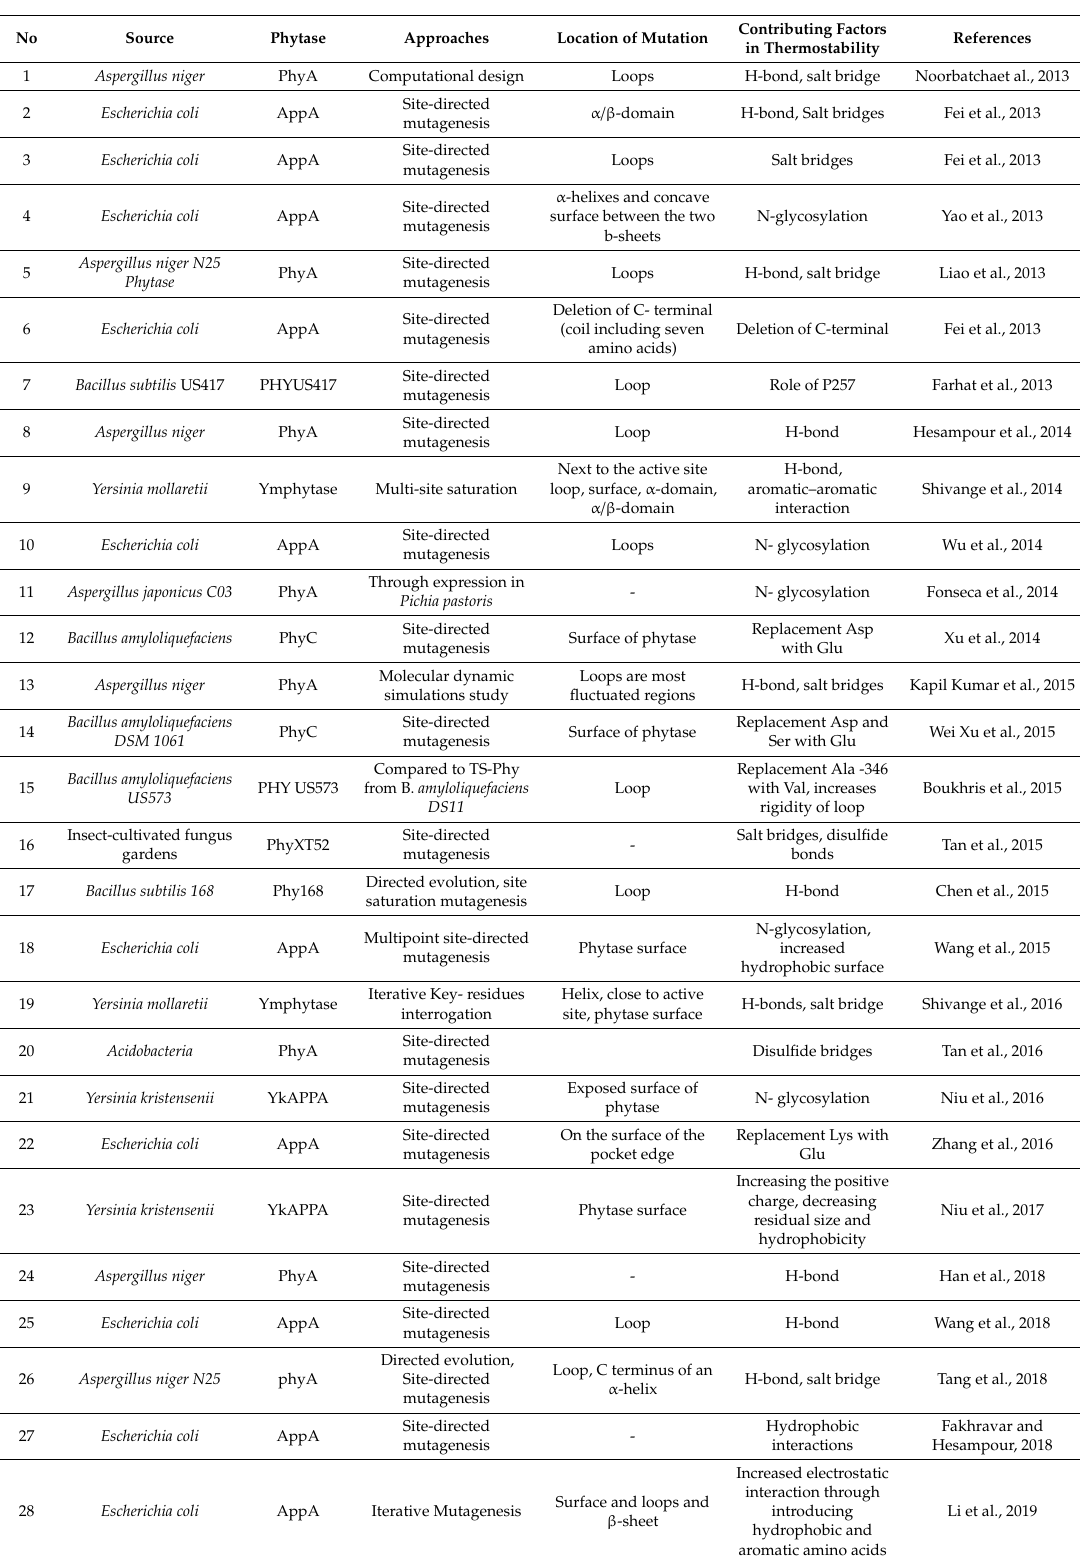
Table 1. Enhancement of the thermostabilities of various microbial phytases via protein